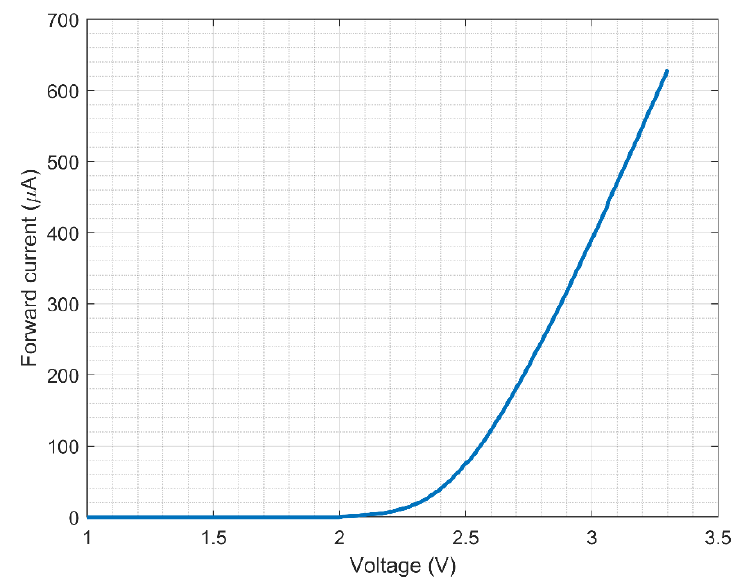
Figure 8. Measured forward current of the surface mount LED [25] with a resistor of 1 kΩ added in series, as a function of the VREGL pin voltage.